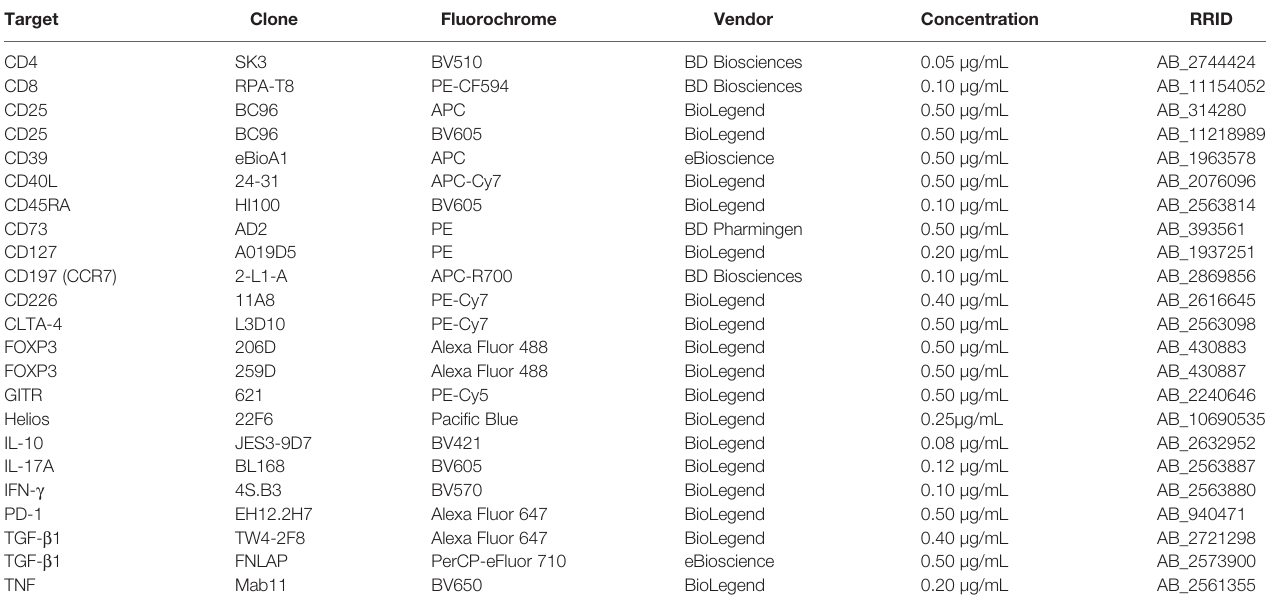
TABLE 1 | Antibodies used for fl ow